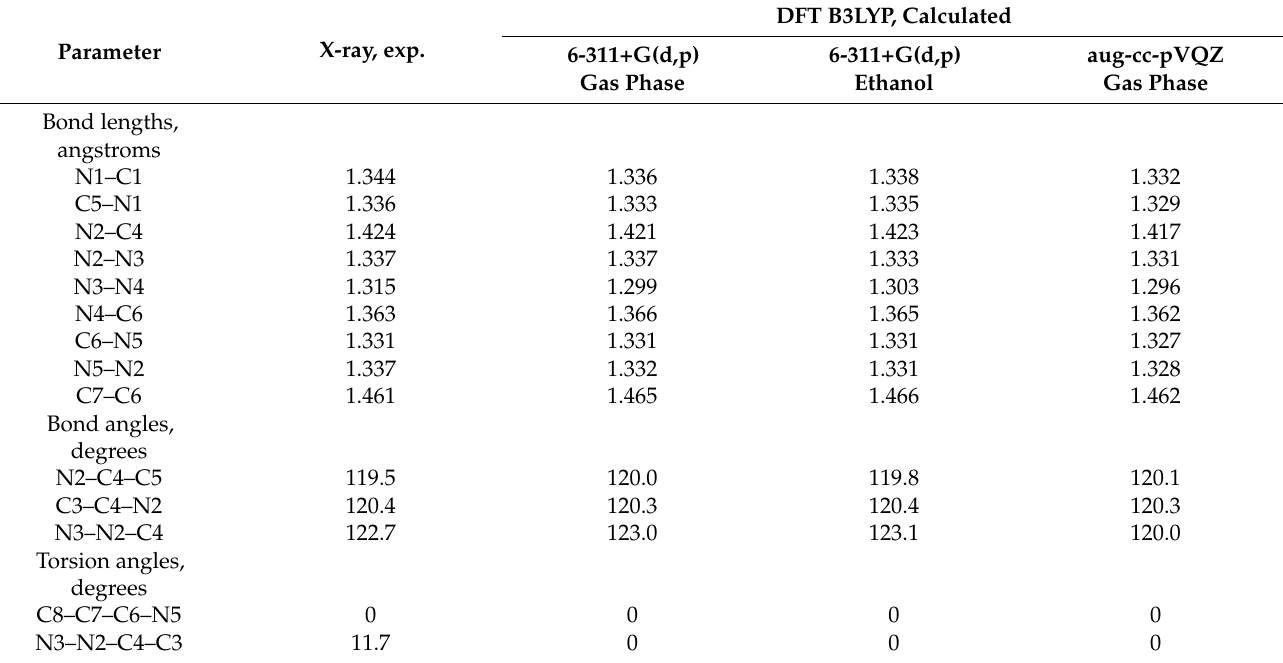
Table 3. Selected geometrical parameters of most preferable rotamer 3-(5-phenyl-2 H -tetrazol-2- yl)pyridine 1a obtained by X-ray analysis and calculated by DFT B3LYP method at different basis sets in the gas phase and ethanol (IEFPCM